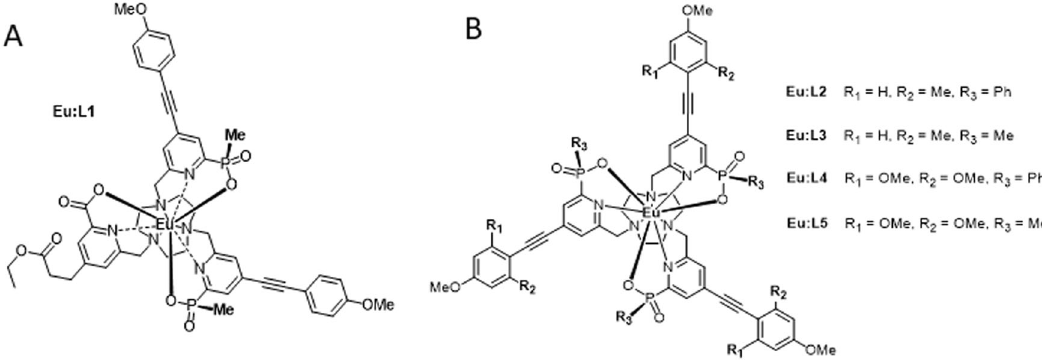
Fig. 1 | Chiral lanthanide complexes discussed as candidates for CPL-active security inks. A Eu:L1, a newly synthesised complex that exhibits desirable strong single sign (exclusively left or right helicity) Δ J=1 and Δ J=2 transitions. B Eu:L2-5, legacycomplexesdemonstratingsuitableCPLspectratobeusedfortime-resolved